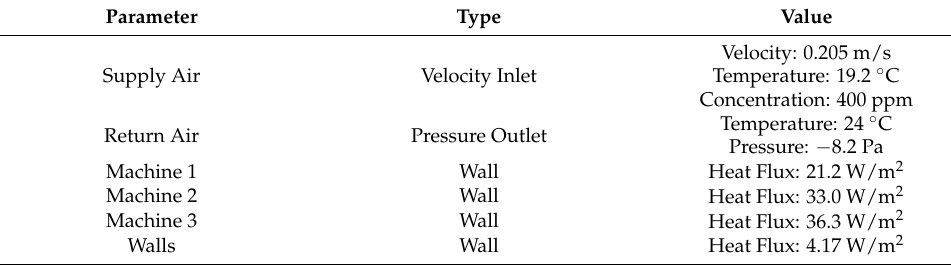
Table 2. The boundary condition for numerical